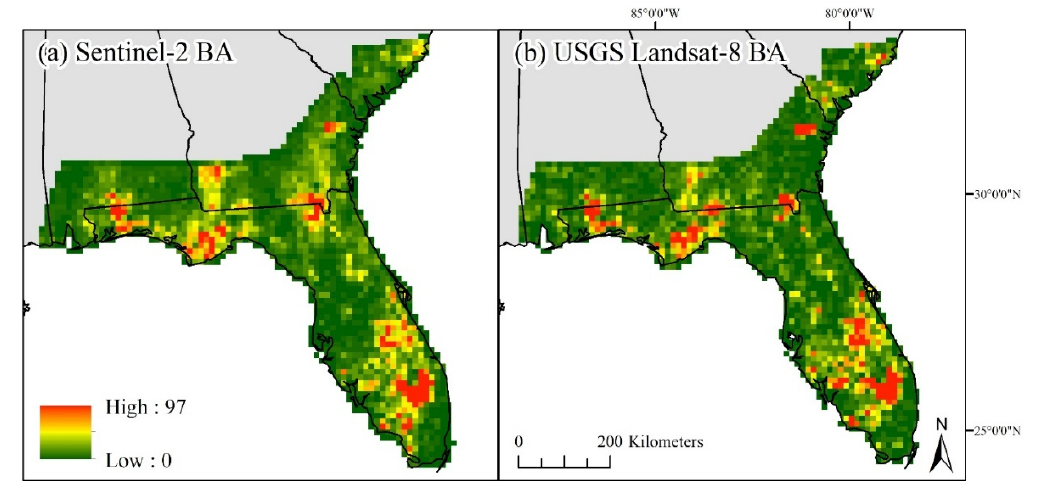
Figure 6. Percent of window (1200 km × 1200 km) burned during the 2016–2019 period, as mapped from ( a ) Sentinel-2 (20 m), and ( b ) Landsat-8 Burned Area Product (30 m). Pixels are generalized for illustrative purposes. Table 4. Detection of burned area within wetland fire perimeters (perim.) by year, fire count, and area for the Landsat-8 (L8) Burned Area (BA) Product; the burned area detected by Sentinel-2 (S2); and the combined efforts (L8 + S2 BA). Fire Perim. Year